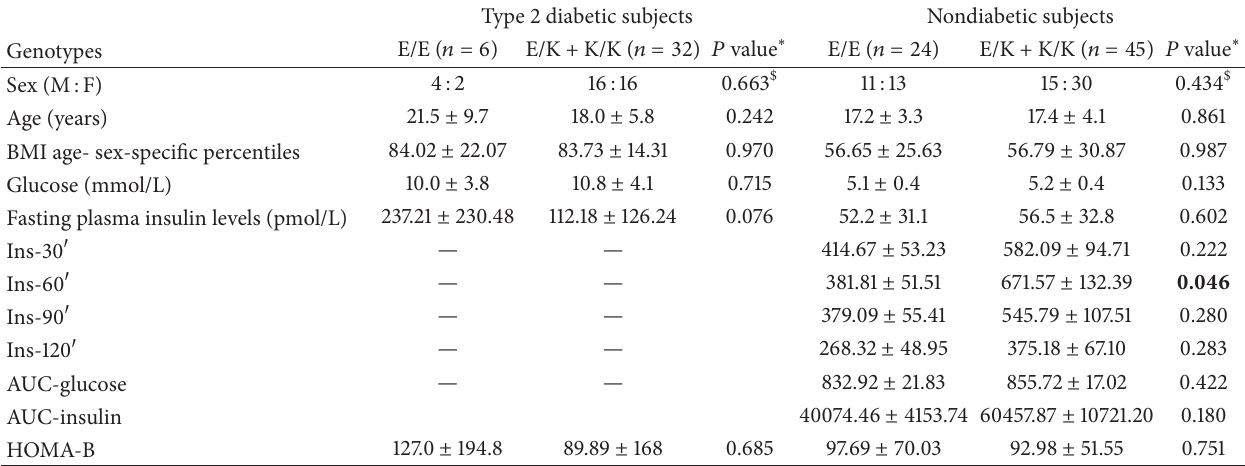
Table 4: Clinical and metabolic features between those with E/E genotype and K-containing allele among type 2 diabetic and nondiabetic subjects,